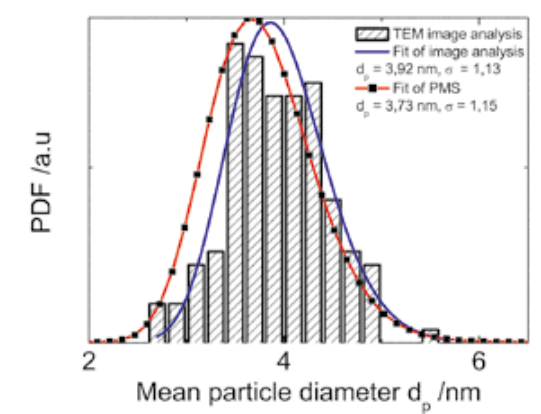
Fig.1 Comparison between PMS measurement and TEM analysis for the formation of SnO 2 nanoparticles taken at 110 mm height above the burner.